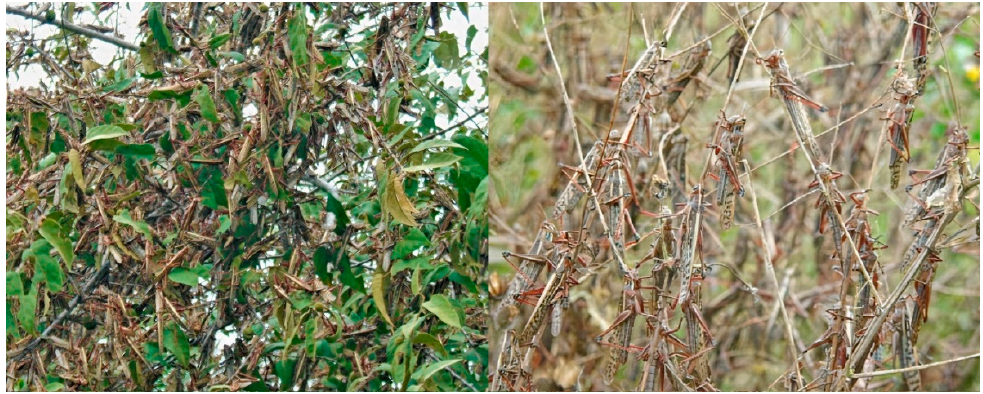
Figure 4. Central American locust, Schistocerca piceifrons piceifrons (Walker, 1870), swarms.